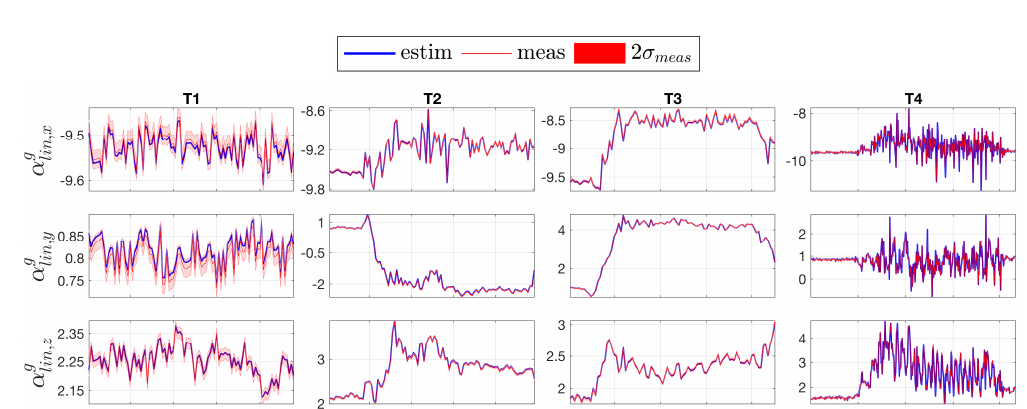
Figure 7. The base linear proper sensor acceleration α g (mean and standard deviation, in red) and floating-base MAP estimation (mean, in blue), for tasks T1, T2, T3 and